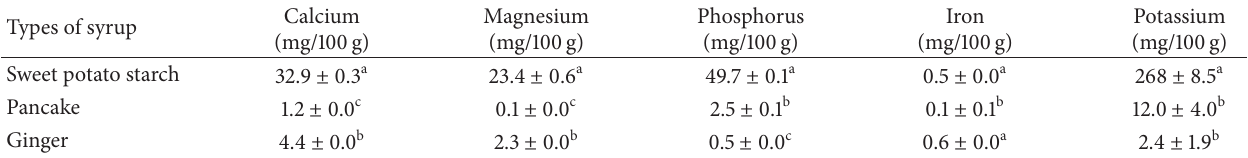
Table 1: Mean mineral content of sweet potato starch, pancake, and ginger